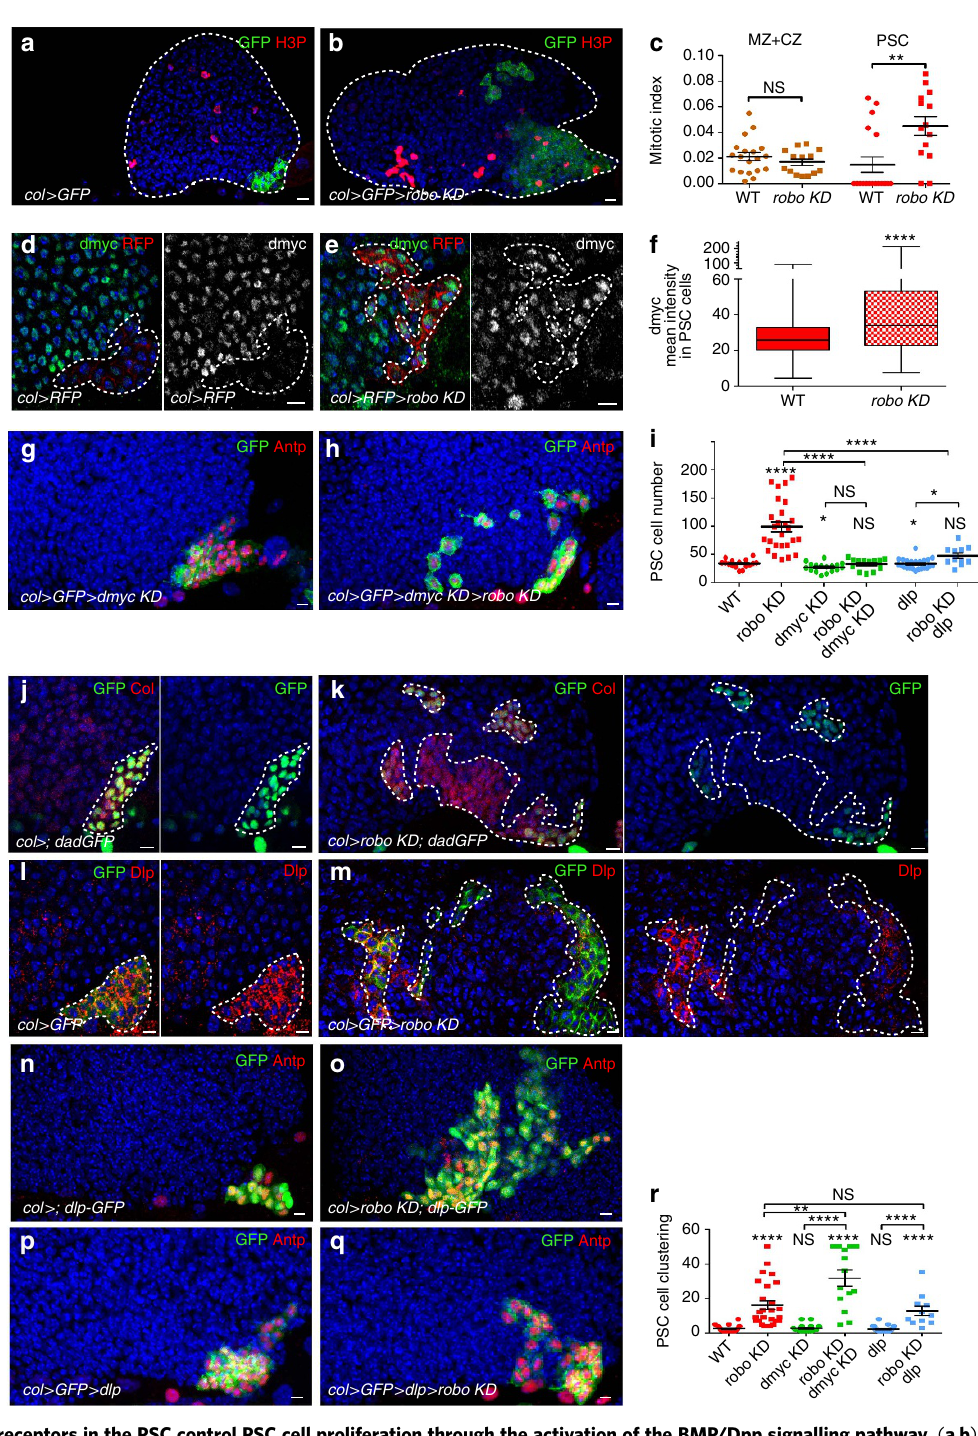
Figure 4 | Robo receptors in the PSC control PSC cell proliferation through the activation of the BMP/Dpp signalling pathway. ( a , b ) Phosphor-histone H3 (H3P) staining (red) in the presence or absence of robos in PSC cells (green). ( c ) Mitotic index in the (MZ þ CZ), and PSC in WT and robo KD LG. ( d – e ) PSC cells express RFP (red) under the PSC col driver in WT ( d ) and in robo KD ( e ). dmyc staining (green, small left panels and white small right panels. ( f ) Quantification of dmyc mean intensity in PSC cells in WTand in robo KD . ( g , h ) PSC cells are stained by Antp (red) and express GFP (Col 4 GFP, green). Reduction of dmyc expression in the PSC ( g ) slightly reduces the number of PSC cells; dmyc reduction in the robo KD PSC rescues the number of PSC cells, but not their clustering ( h ). ( i , r ) Quantification of PSC cell numbers ( i ) and PSC cell clustering ( r ) under various mutant conditions. ( j , k ) Daughters against dpp-GFP (dad-GFP, green) are expressed in PSC cells labelled by Col (red). Compared with WT ( j ) robo KD PSC ( k ) expresses a lower level of dad-GFP. ( l , m ) Dally-like (dlp, red) is expressed in PSC cells labelled by GFP (green). Compared with control ( l ), robo KD PSC ( m ) expresses a lower level of Dlp. ( n , o ) PSC cells express GFP (green) and are stained by Antp (red). ( p , q ) Antp (red) and Dlp-GFP (green) label PSC cells in WT ( p ) and robo KD ( q ). All PSC cells express GFP both in WTand robo KD . The overexpression of Dlp in the PSC slightly reduces the number of PSC cells ( i , r ); in robo KD , this restores a WT number of PSC cells, but not their clustering ( i , p – r ). Statistical analysis t -test (Mann–Whitney nonparametric test) is performed using GraphPad Prism 5 software. Scale bars, 10 m